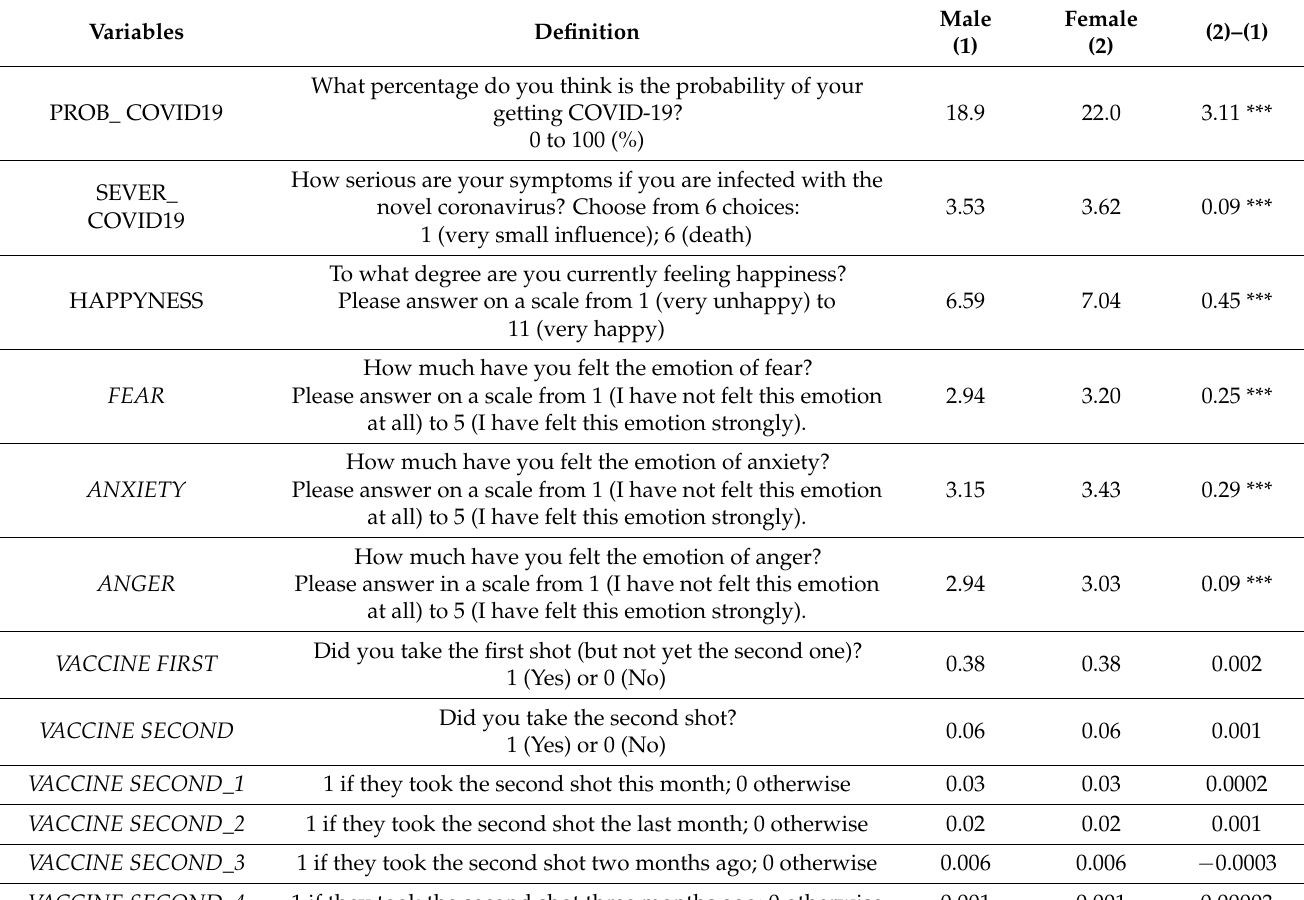
Table 1. Definitions of key variables and their mean difference tests between males and